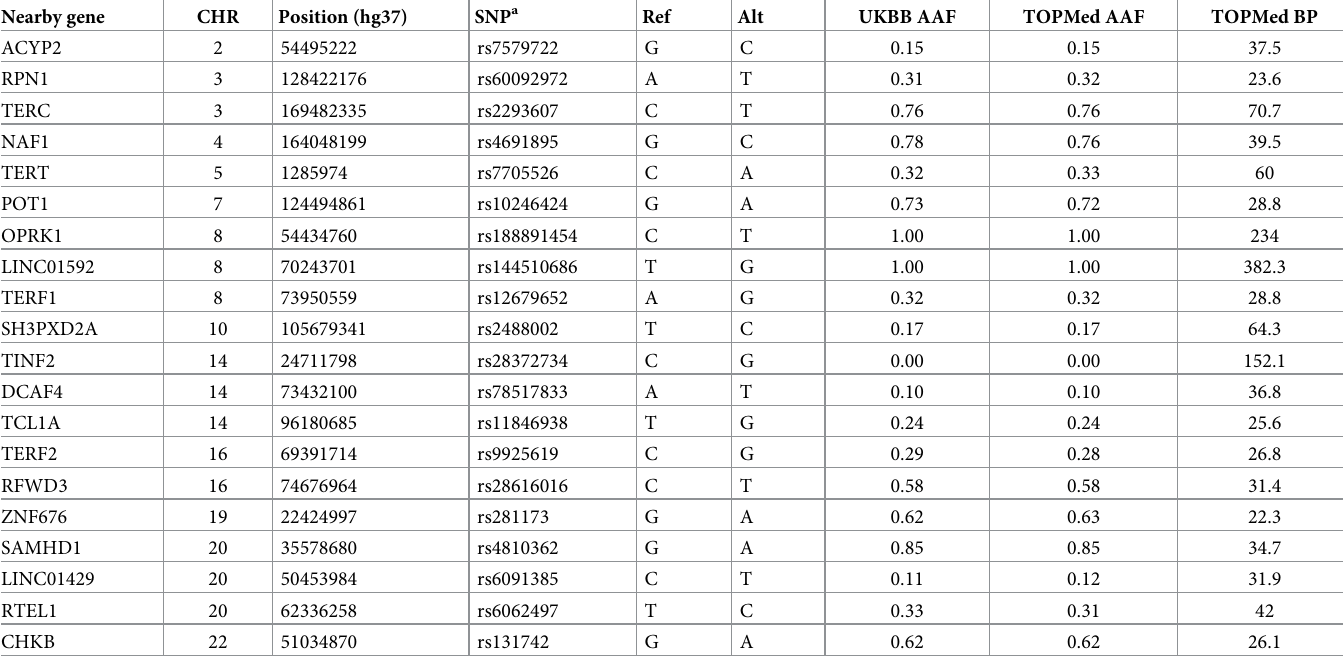
Table 4. Significant telomere length-associated germline genetic variants identified from TOPMed analysis. Nearby